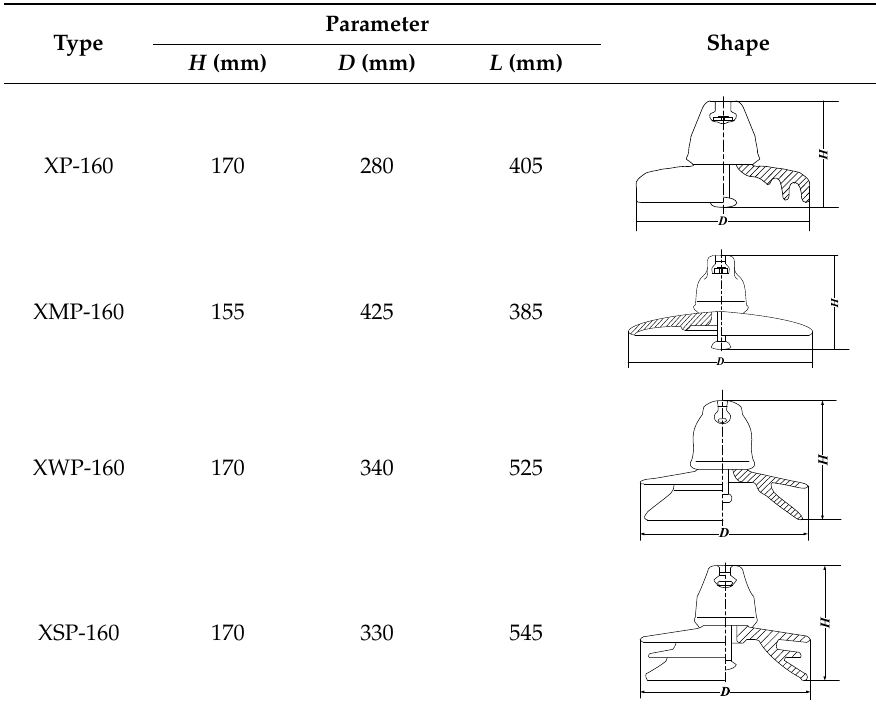
Table 2. Parameter and structure of insulator.